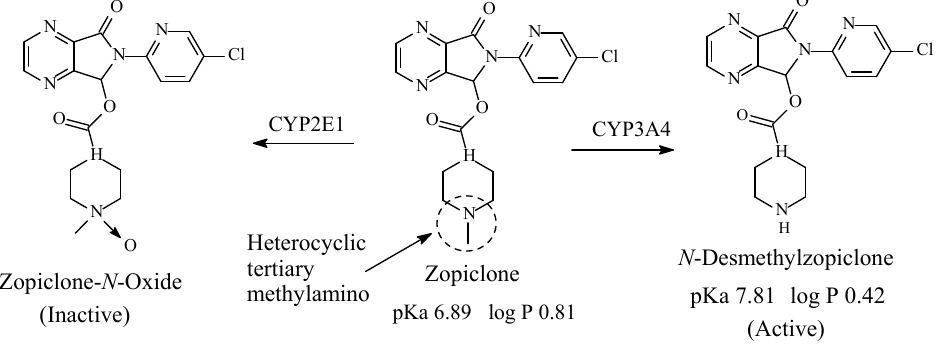
Figure 33. Metabolic pathways of zopiclone.